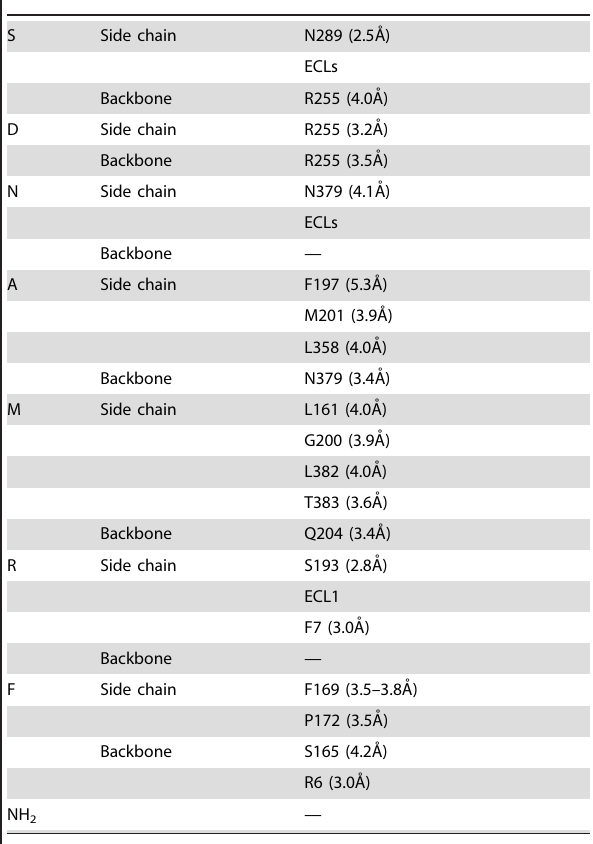
Table 13. SDNAMRF-NH 2 ligand-receptor contact sites a .